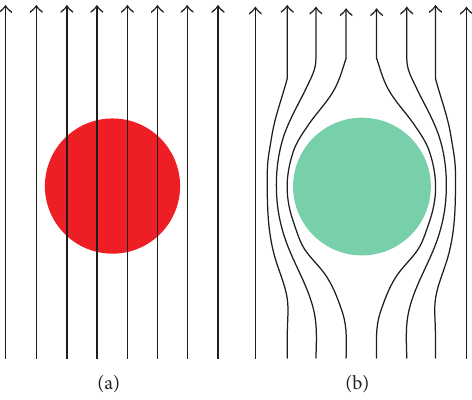
Figure 9: (a) Magnetic field lines penetrate through a supercon- ductor at a temperature above its critical superconducting transition temperature (𝑇 > 𝑇 𝐶 ) .(b)Whenthesuperconductoriscooledbelow its critical transition temperature (𝑇 < 𝑇 𝐶 ) , magnetic field lines are expelledfromtheinteriorofthesuperconductorduetotheMeissner